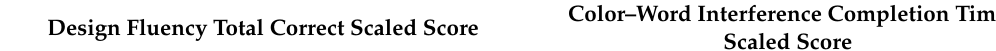
Table 3. Sex-stratified results of multivariable linear regression analyses (difference in scaled scores associated with a twofold increase in exposure and 95% CI) 1 assessing the relation of prenatal exposure to a five-chemical mixture with Delis–Kaplan Executive Function System inhibition scaled scores among adolescents in the main analysis group 2